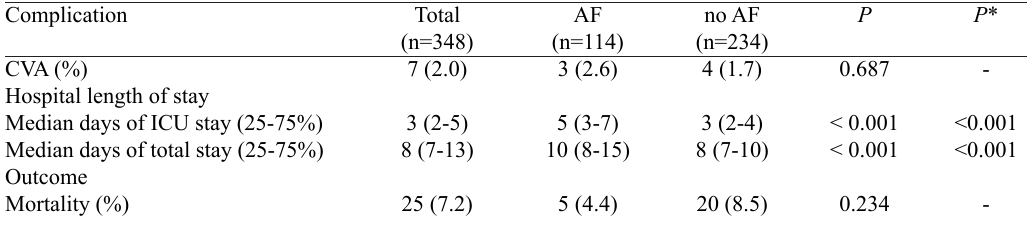
Table 3. Incidence of CVA, hospital length of stay, and hospital mortality according to the incidence of postoperative AF.